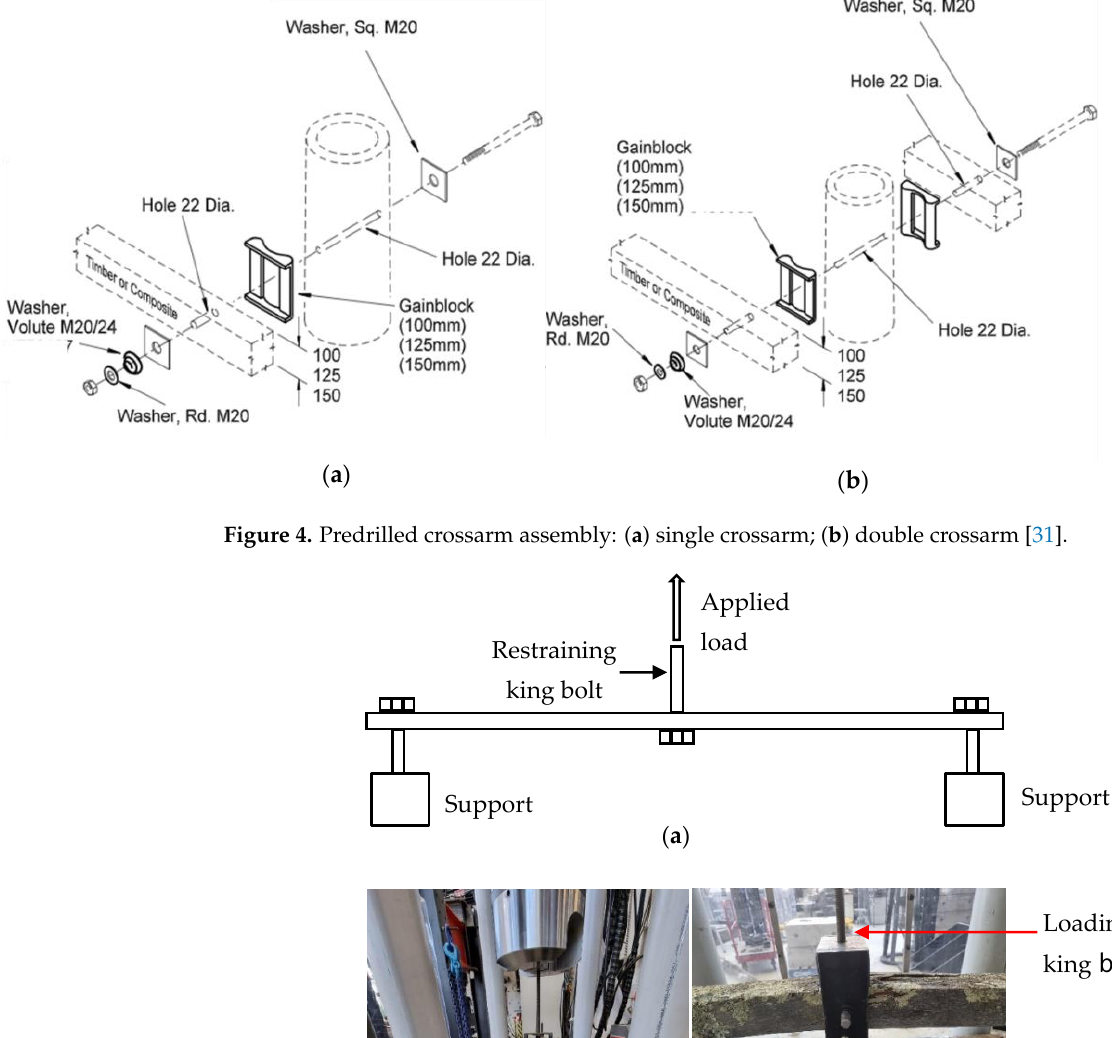
Figure 5. Three-point bending test setup: ( a ) schematic representation; ( b ) actual test setup.